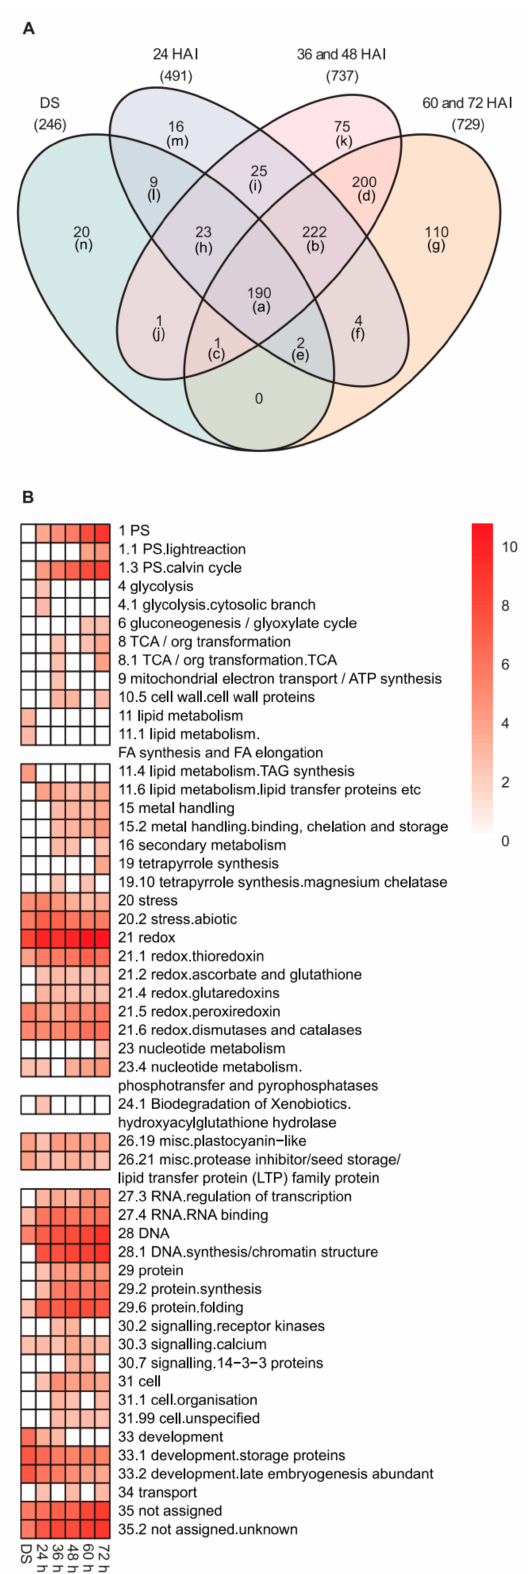
Figure 4. Heat-stable proteins in dry seeds (DS), germinating seeds and seedlings. ( A ) Venn diagram showing common and unique heat-stable proteins at the indicated time points after imbibition. ( B ) Functional enrichment of MapMan terms in the heat-stable proteome of DS, germinating seeds and seedlings. The white/red color gradient represents z-scores calculated from p -values ( p <